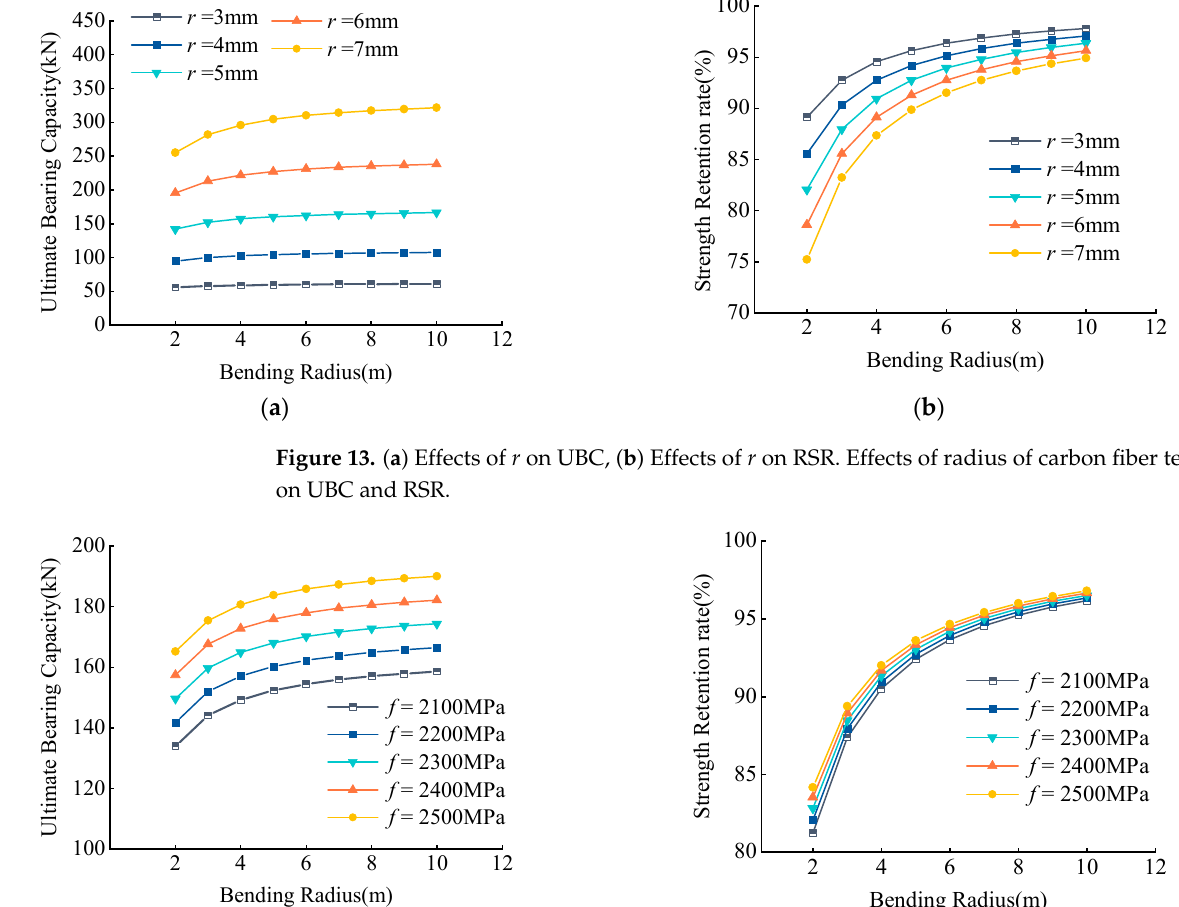
of decrease was large.